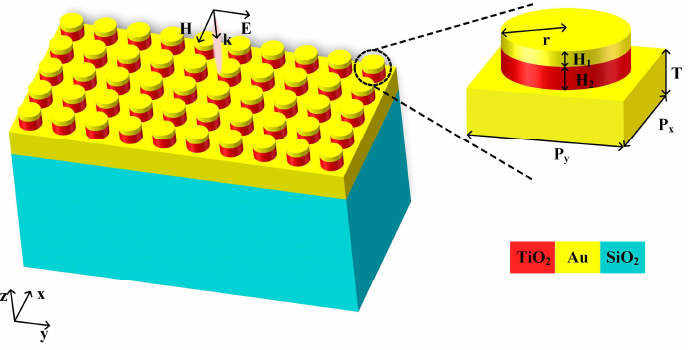
Figure 1. Schematic of the proposed metasurface and the enlarged view of the unit-cell. A plane wave polarized in the y direction at normal incidence is exploited to investi-